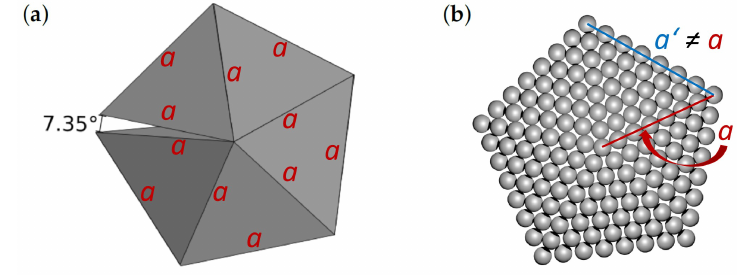
Figure 1. Schematic visualizations of ( a ) five tetrahedrons forming an imperfect decahedron with a gap of 7.35 ◦ and ( b ) one of the studied decahedral nanoclusters/nanoparticles (see below) without the gap. A characteristic length a defined here is used below when defining the shape